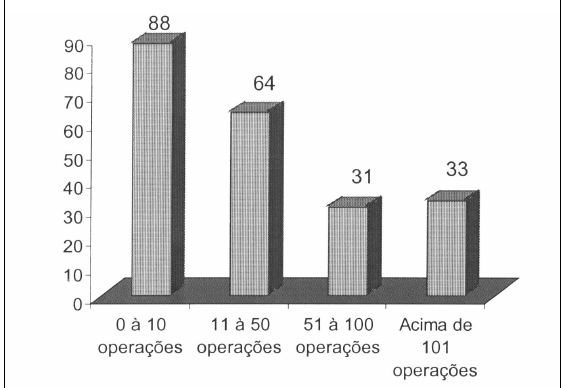
Fig. 1 - Distribuição dos hospitais que realizaram os implantes, agrupa- dos por número de procedimentos realizados no ano de 1999.